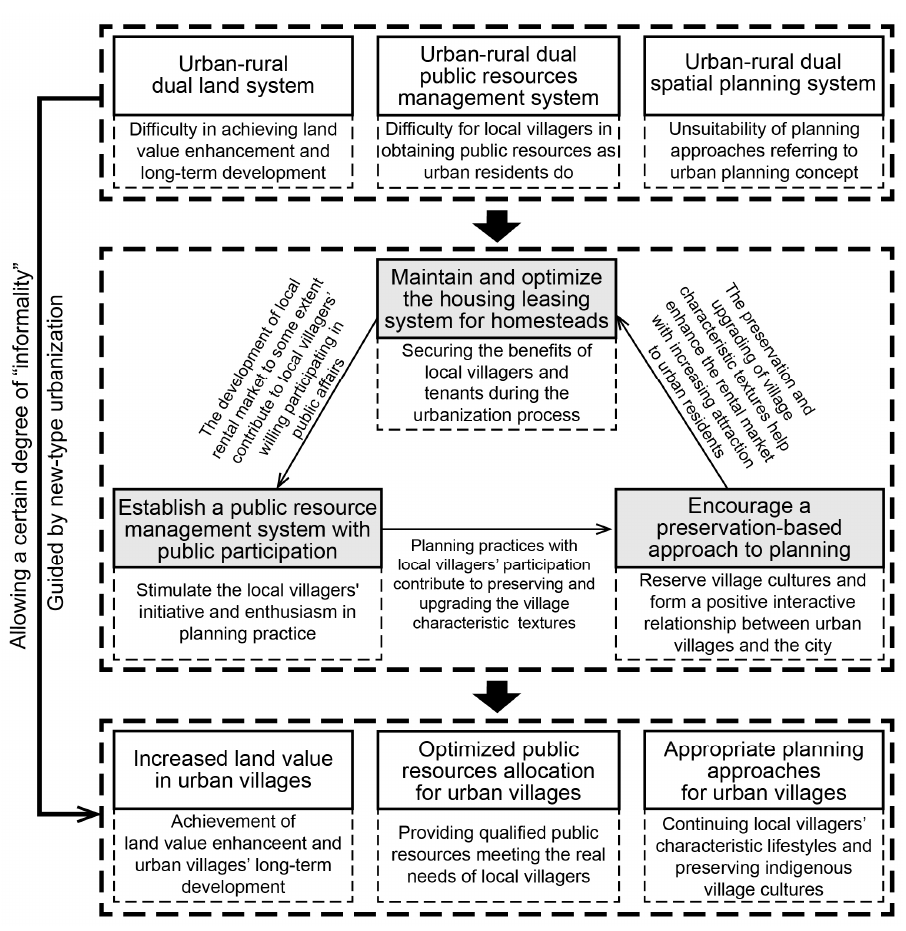
Figure 13. Diagram of planning policies and practices allowing some degree of informality guided by new-type urbanization.